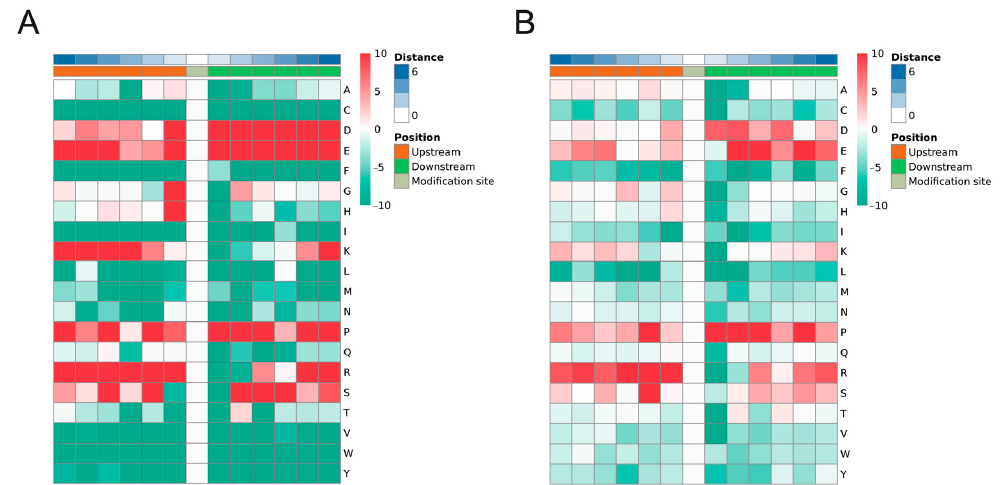
Figure 3. Motif analysis of phosphorylation sites. The motif enrichment heat map of upstream and downstream amino acids of all identified S ( A ) and T ( B ) modification sites. The red color represents significant enrichment of this amino acid near the modification site, and the green color represents a significant decrease in this amino acid near the modification site.